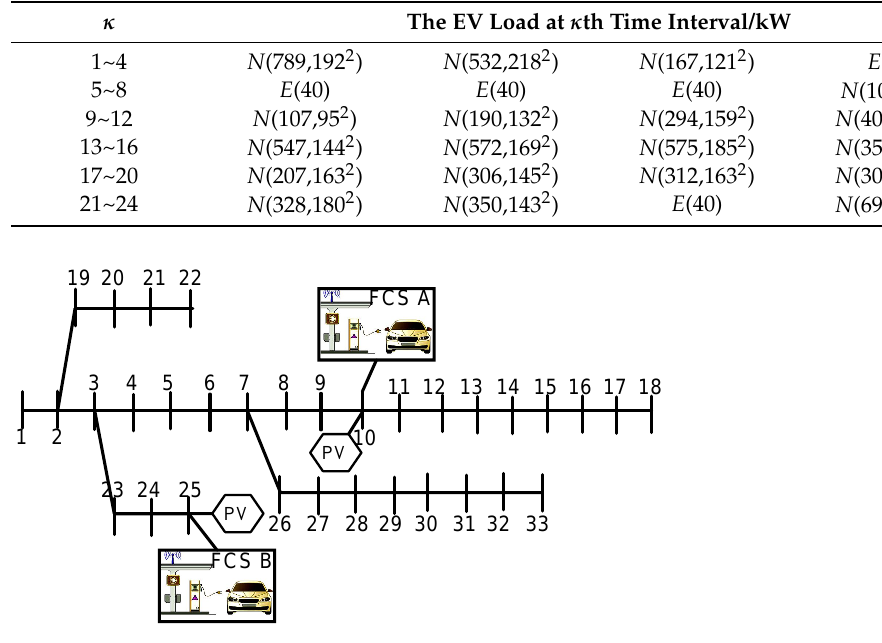
Figure 5. IEEE 33-bus test system.